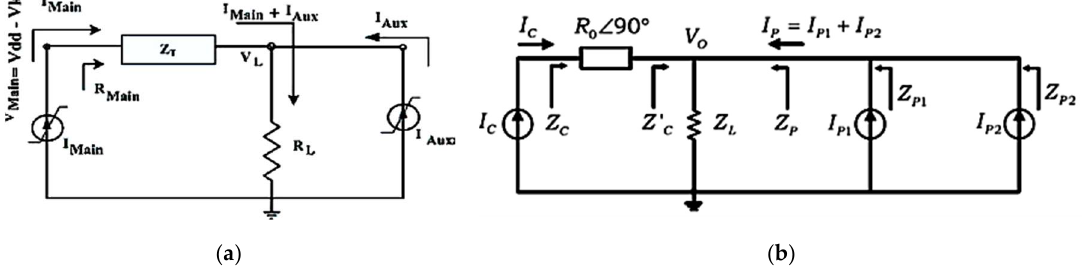
Figure 13. Structure of equivalent circuit of ( a ) Two-way, and ( b ) Three-stage DPA [84].